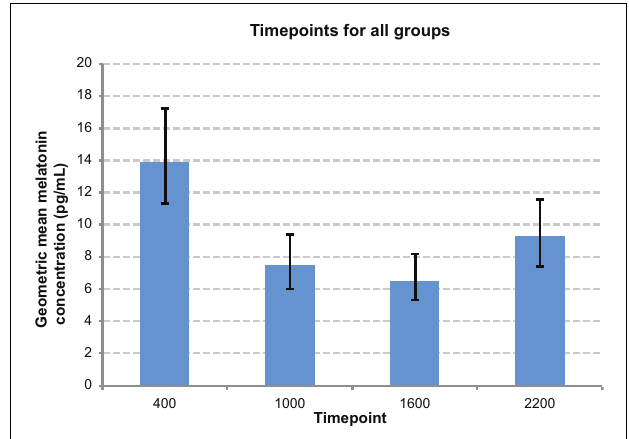
FIGURE 5 | Comparison graph of time point effect . Night-time timepoints (0400h and 2200h) were significantly elevated compared to daytime time points, and 0400h significantly higher than 2200h.